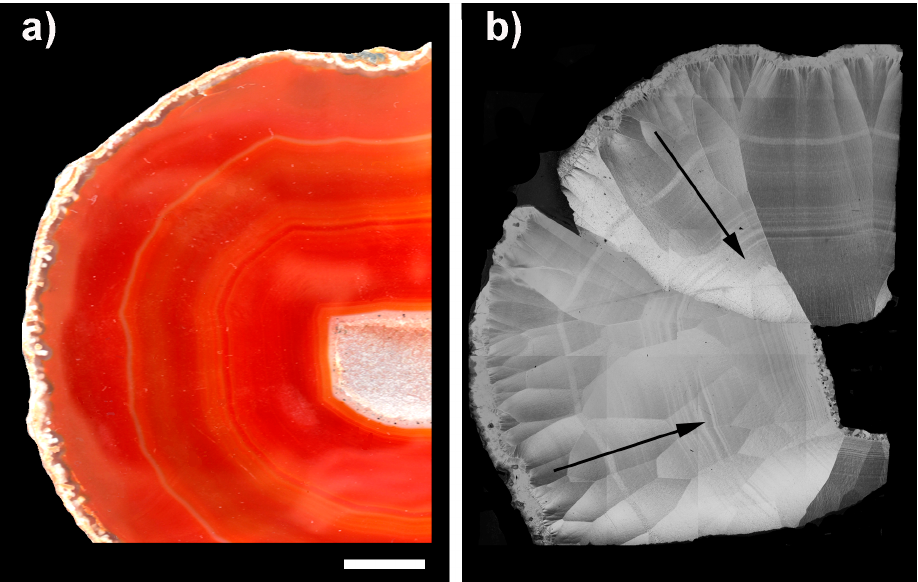
Figure 3. ( a ) A Brazilian agate that has been dyed to a depth of around 2 mm. ( b ) The thin section that was made from a slab just below the dyed surface. Note the wall contact layer shows a different texture to the main microstructure. The arrows indicate the direction of growth leading to a final development of macrocrystalline quartz crystals. Polars crossed. Scale bar = 2 cm.